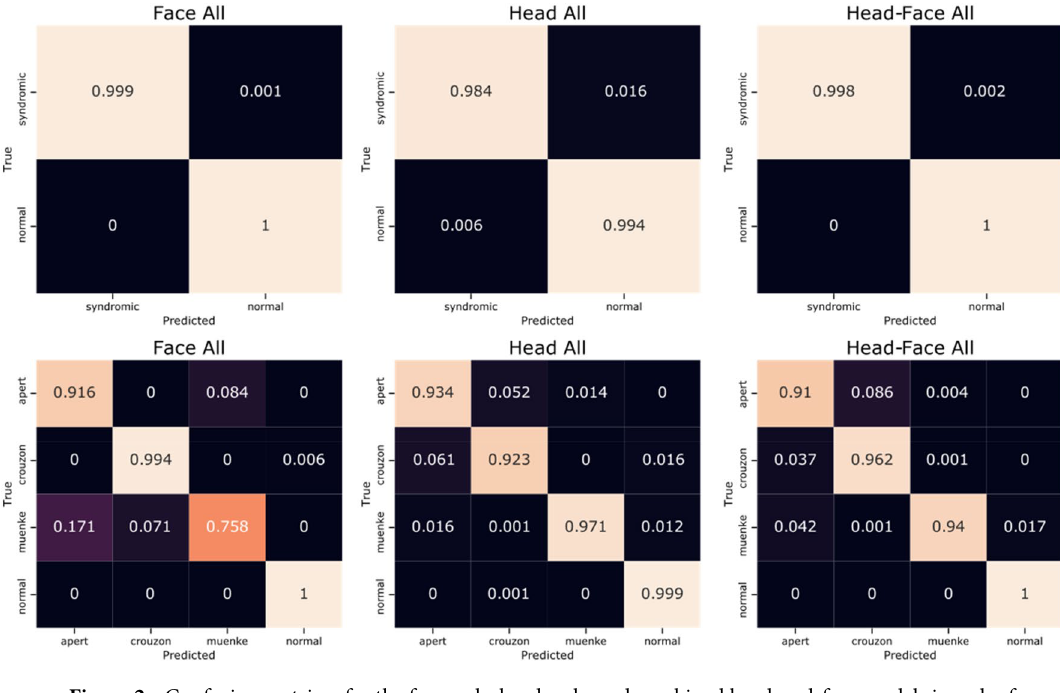
Figure 2. Confusion matrices for the face-only, head-only, and combined head-and-face models in order from left to right. Top row: binary classification. Bottom row: multi-class classification.